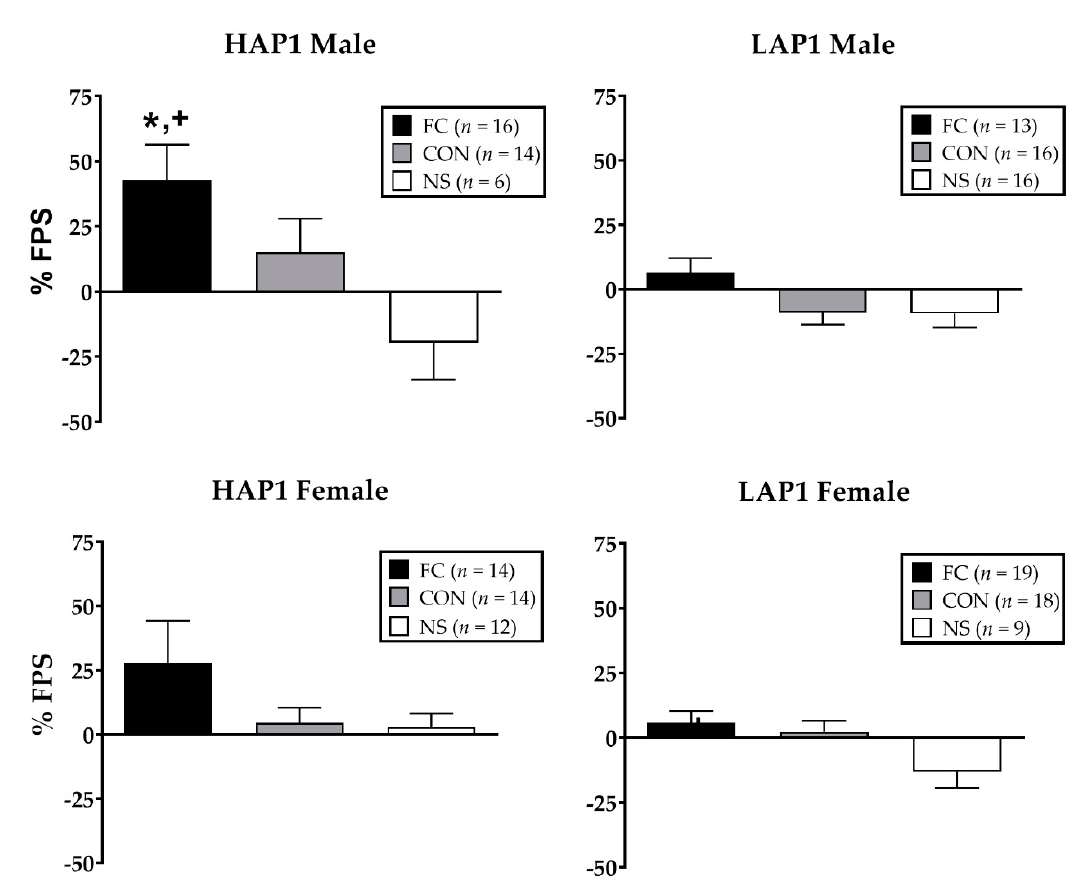
Figure 1. Mean ( ± SEM (standard error of the mean)) % FPS (fear-potentiated startle) in HAP1 (high alcohol preferring; left panels) and LAP1 (low alcohol preferring; right panels) mice in the fear-conditioned (FC; paired light + shock), control (CON; unpaired light and shock), and no-shock (NS; light only) groups for experiment 1. * p < 0.01, HAP1 > LAP1; + p < 0.01, FC > CON, NS (no-shock group).Analysis of % FPS in fear-conditioned HAP1 and LAP1 females as a function of their estrous stage on the FPS test day indicated a main effect in LAP1 mice only (F(3,15) = 4.7, p < 0.05). Tukey’s post-hoc analyses indicated that % FPS of LAP1 mice in D stage (36.6 ± 9.2, n = 3) was significantly greater than those in E ( − 3.6 ± 5.6, n = 8, p = 0.01) and M (2.8 ± 7.1, n = 5, p < 0.05) stages.